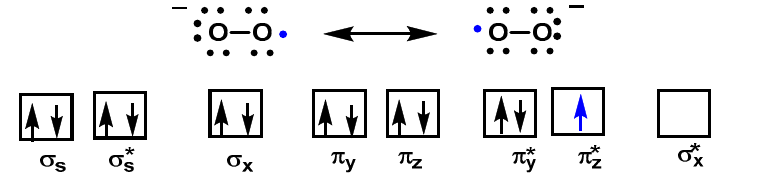
Figure 3. The molecular orbital of O 2•– shows one unpaired electron and is delocalized between the π * orbitals of the two oxygen atoms.